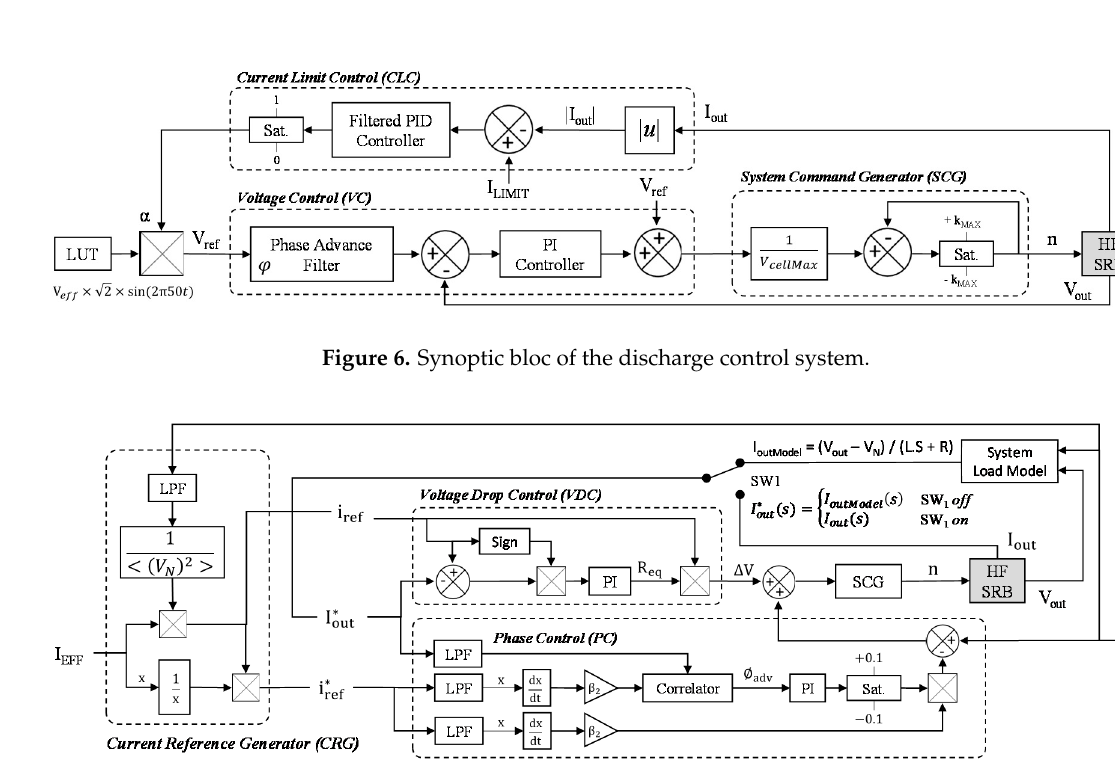
Figure 7. Synoptic bloc of the charge control system.